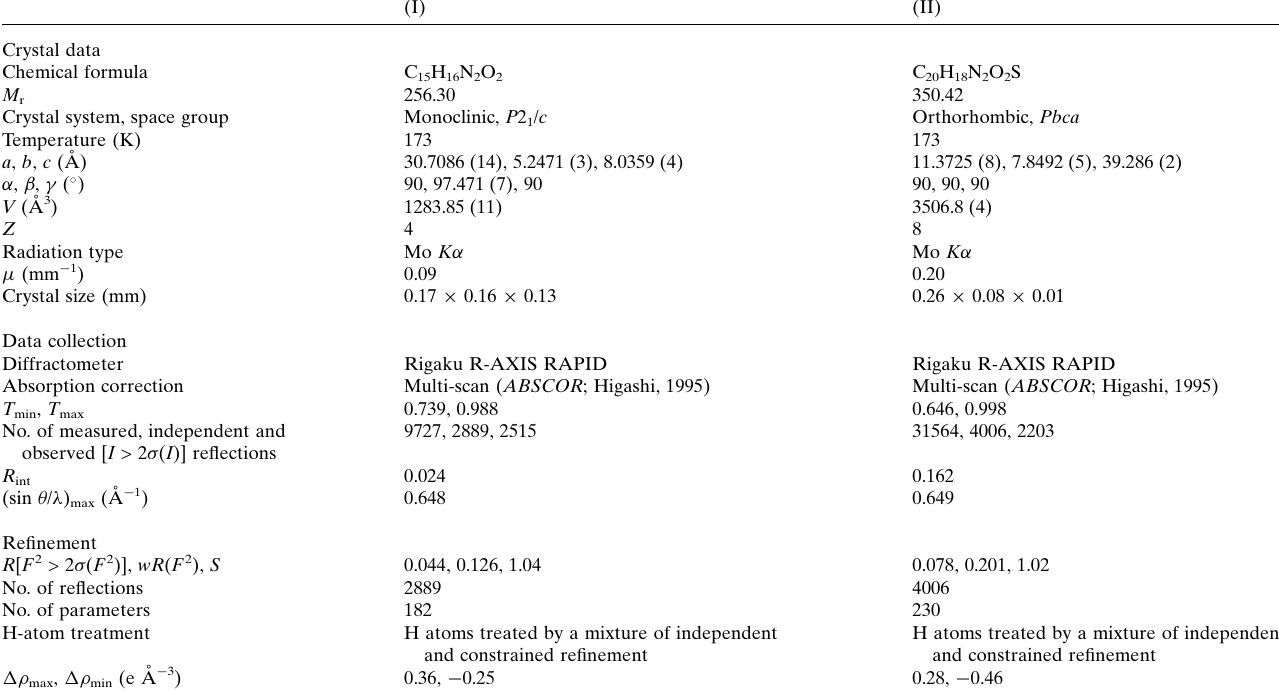
Table 3 Experimental details.